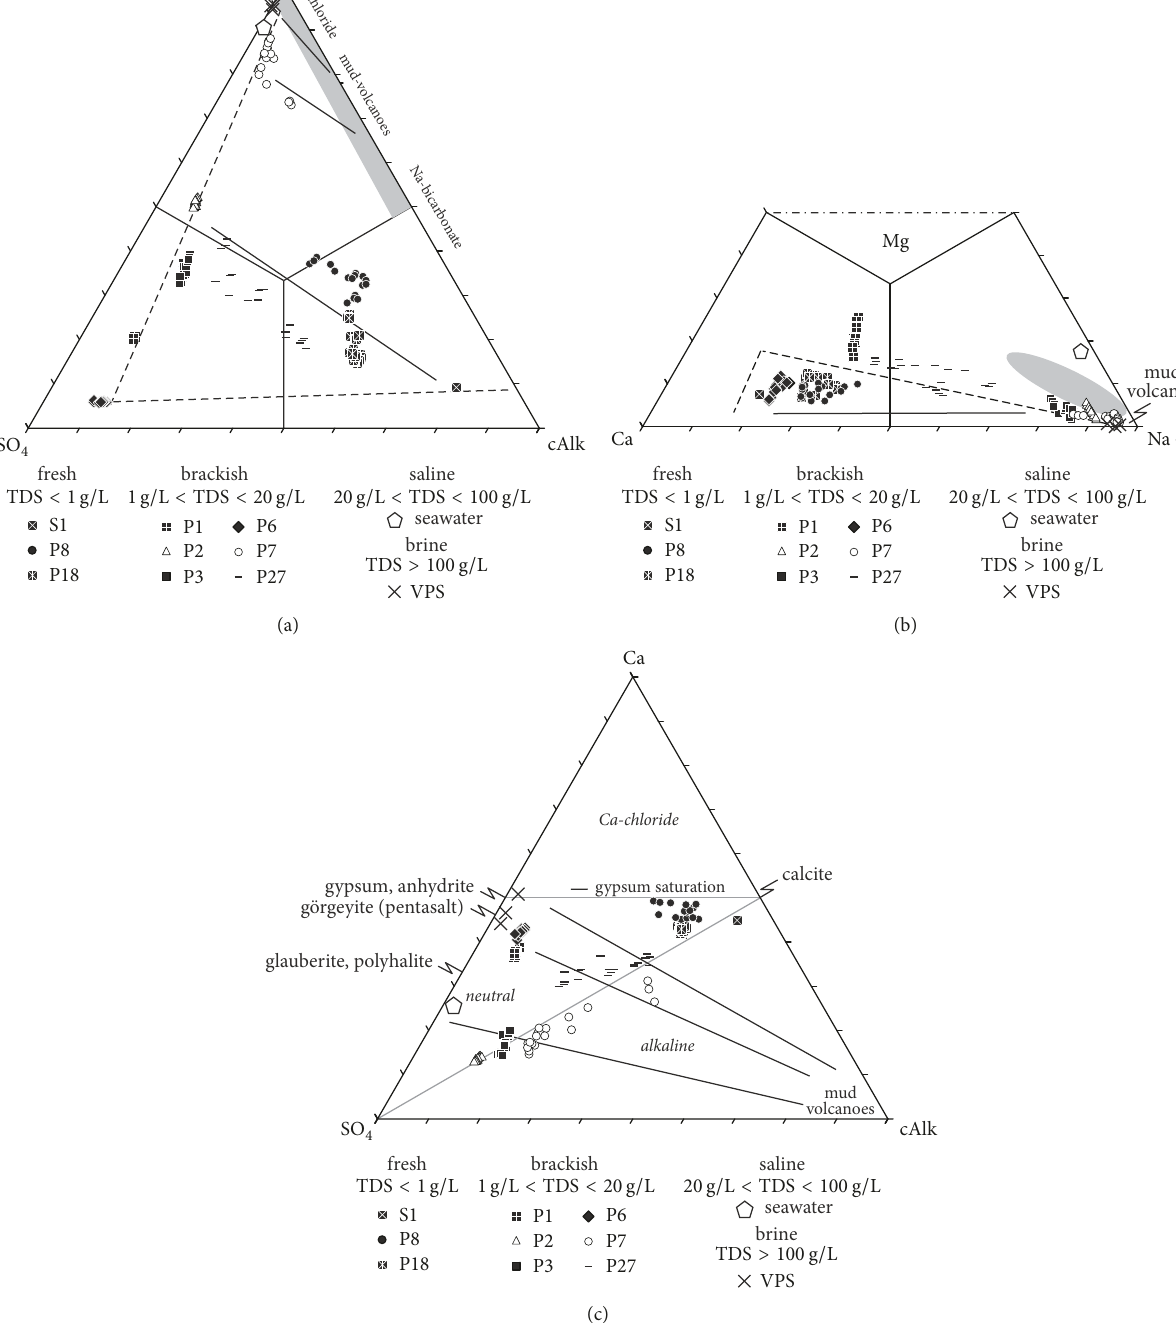
Figure 4: Major ions classification ((a) and (b)) and brine (c) ternary diagrams of the borehole and spring waters sampled at Pozzo del Sale (modified after [17]). In (a) and (b), grey area shows the compositional range of the Messinian Ca-chloride formational fluids from the Northern Apennines (Ca ternary subdiagram in (c) [18]), whereas dashed line represents chemical evolution pathway of a typical evaporite- dissolving groundwater (after [19]). Arrows depict possible mixing trends. Seawater is also shown as